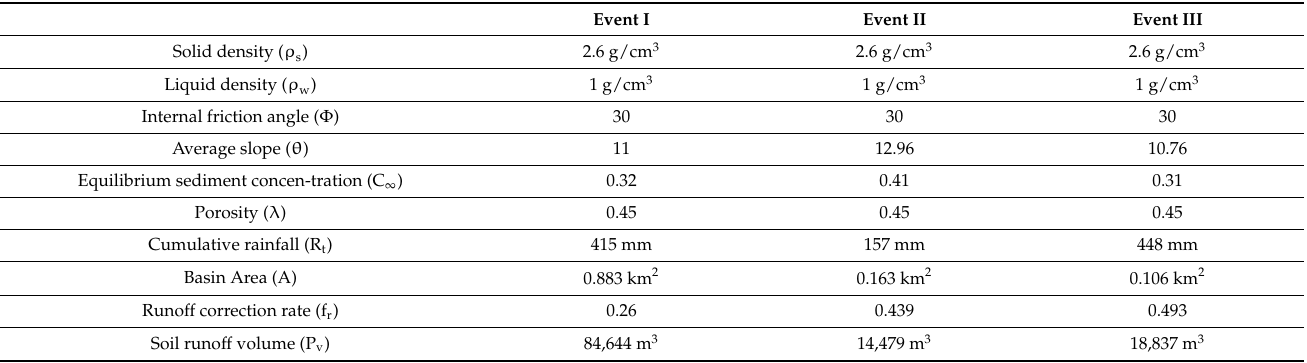
Figure 11. GIS Input Data for the S-RAT. ( a – f ) S-RAT input data of Event I Sinnam Village, ( g – l ) S-RAT input data of Event II Namsan Village, ( m – r ) S-RAT input data of Event III Sungduk Village. Table 2. Input variables required to calculate soil runoff